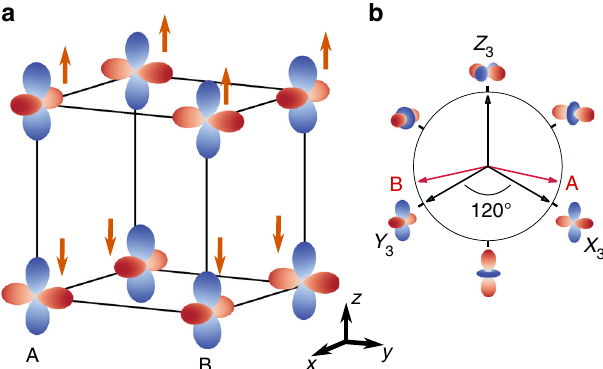
Fig. 1 Spin- and orbital-ordered phase in equilibrium. a The spin-orbital order in a cubic environment in equilibrium. Each site contains three electrons and the unoccupied orbital is shown, with arrows labelling the total spin moment of the electrons. The color scale indicates the value of orbital spherical harmonics in arbitrary units. b The Z 1 – Z 3 plane in the orbital pseudospin space (the compass). The X 3 , Y 3 , Z 3 directions and their corresponding orbitals are marked on the compass. The hole-occupied orbitals on A and B lattice sites are shown as red